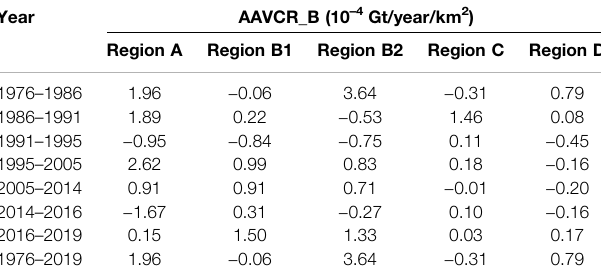
TABLE 4 | AAVCR_B of lakes in different regions and periods from 1976 to